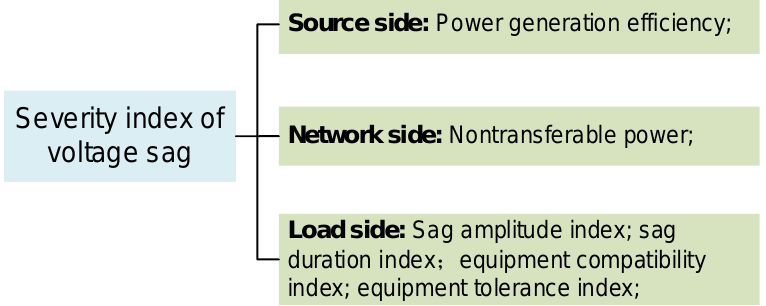
Figure 1. Voltage sag severity index